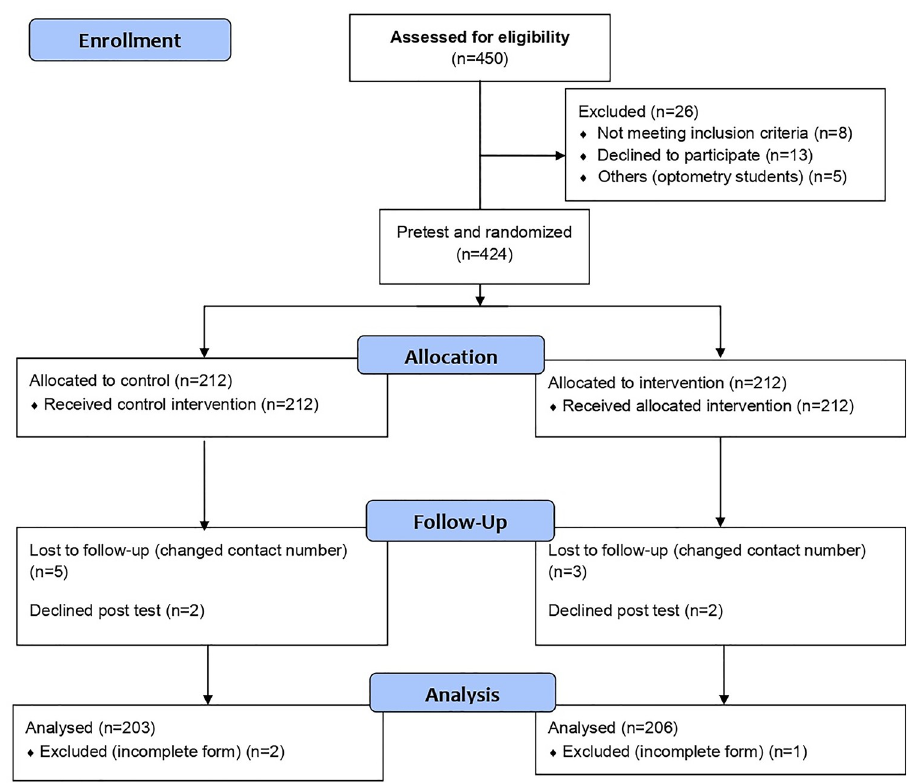
Fig 2. The participant flow from enrollment through